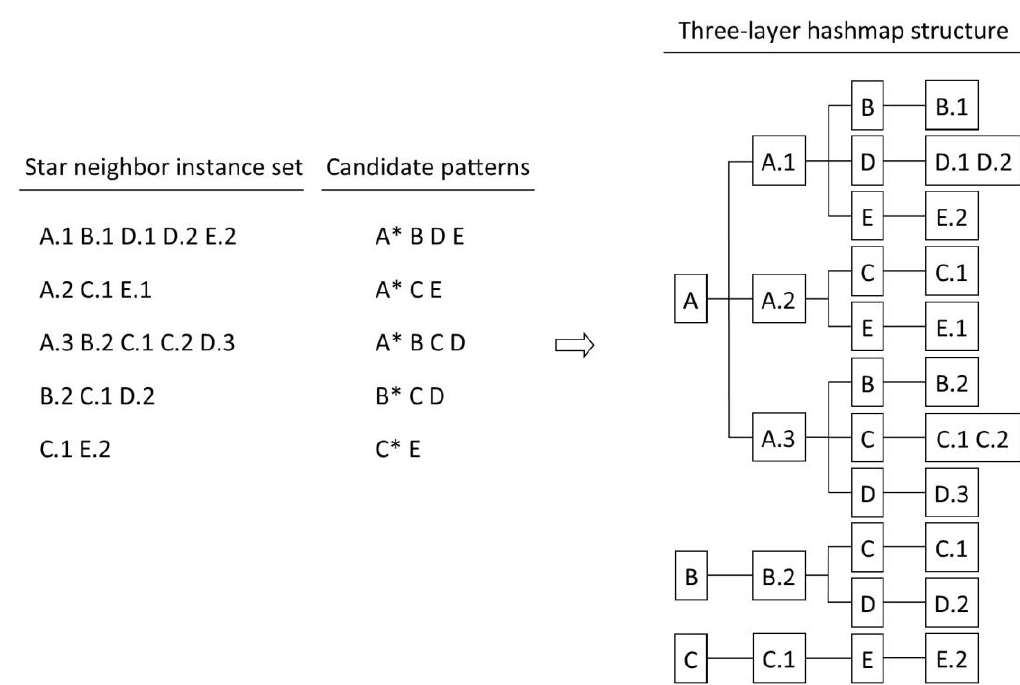
Figure 5: Figure 4. An illustration that shows the star neighbor instance set, candidate patterns, and three-layer hashmap